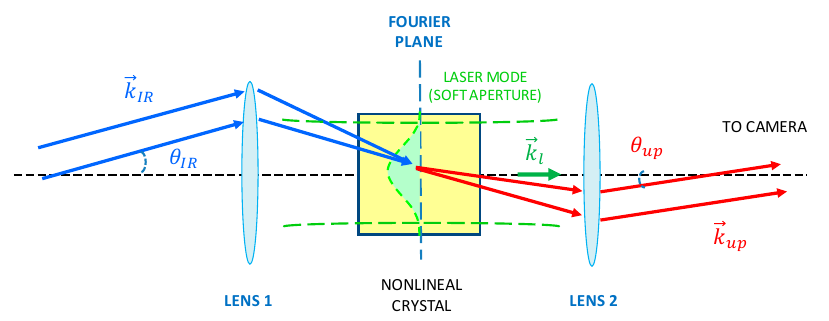
Figure 3. Telescope configuration for SFM image up ‐ conversion.